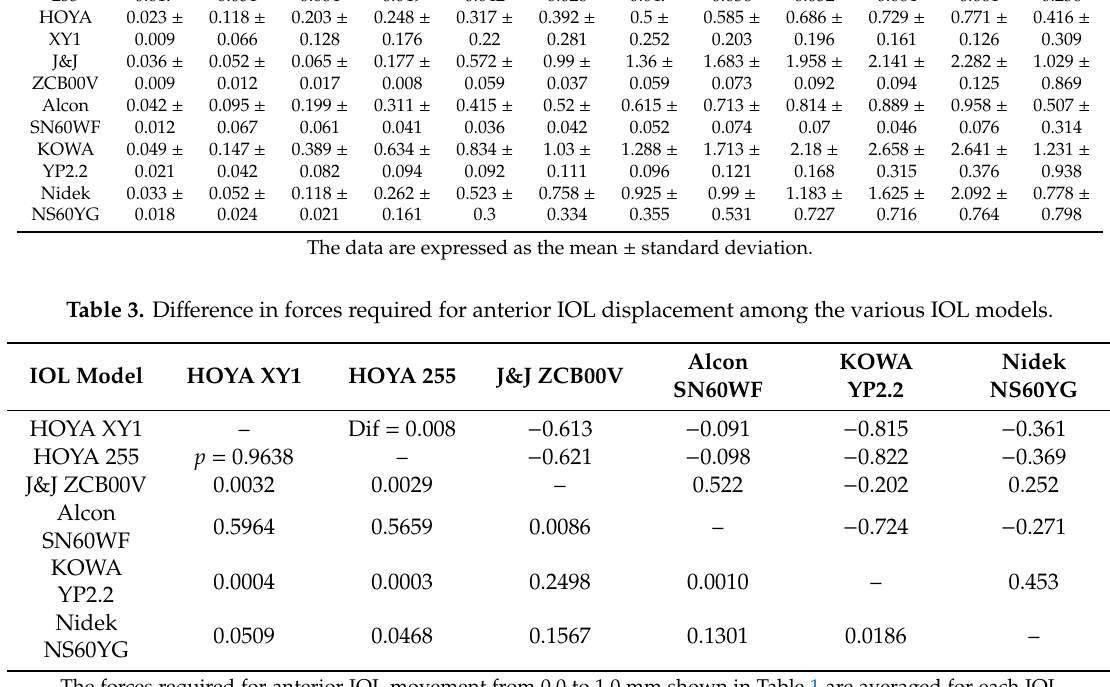
each IOL model. Dif (right upper cells) = least-squares mean difference between each pair of IOLs